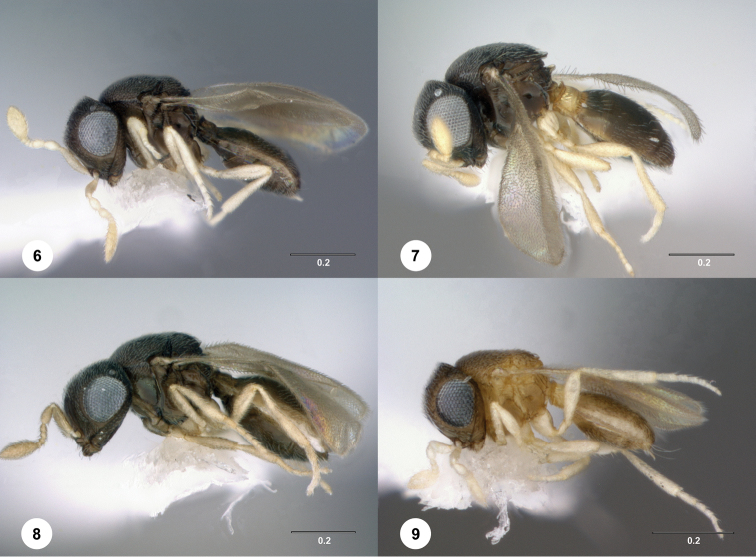
Lateral habitus. 6Idrisbadius sp. n. 7I.balteus sp. n. 8I.curtus sp. n. 9I.fusciceps sp. n. Scale bars in millimeters.